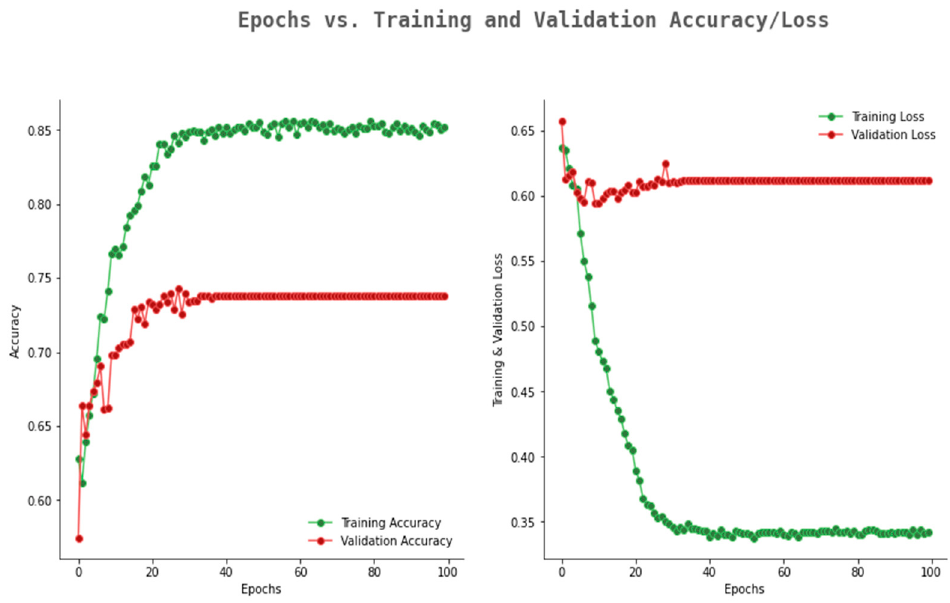
Figure 8. Accuracy loss graph of VGG19.